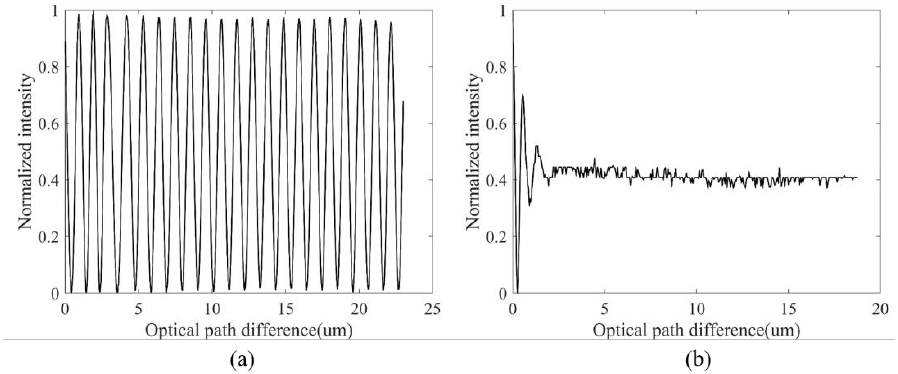
Figure 6. Variation in interference light intensity with optical path difference. ( a ) The 1053 nm light and ( b ) the wide-spectrum halogen light.